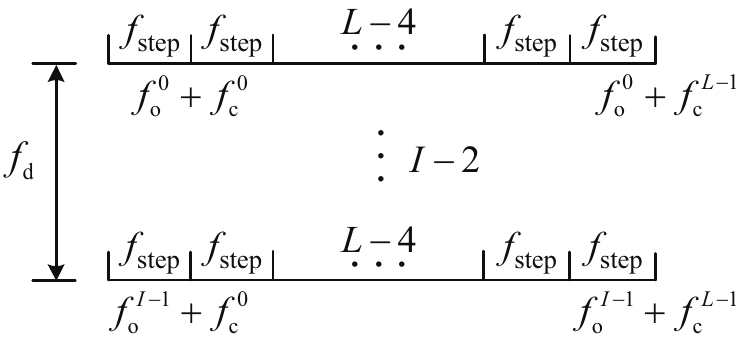
Figure 2. Schematic diagram of frequency domain compression